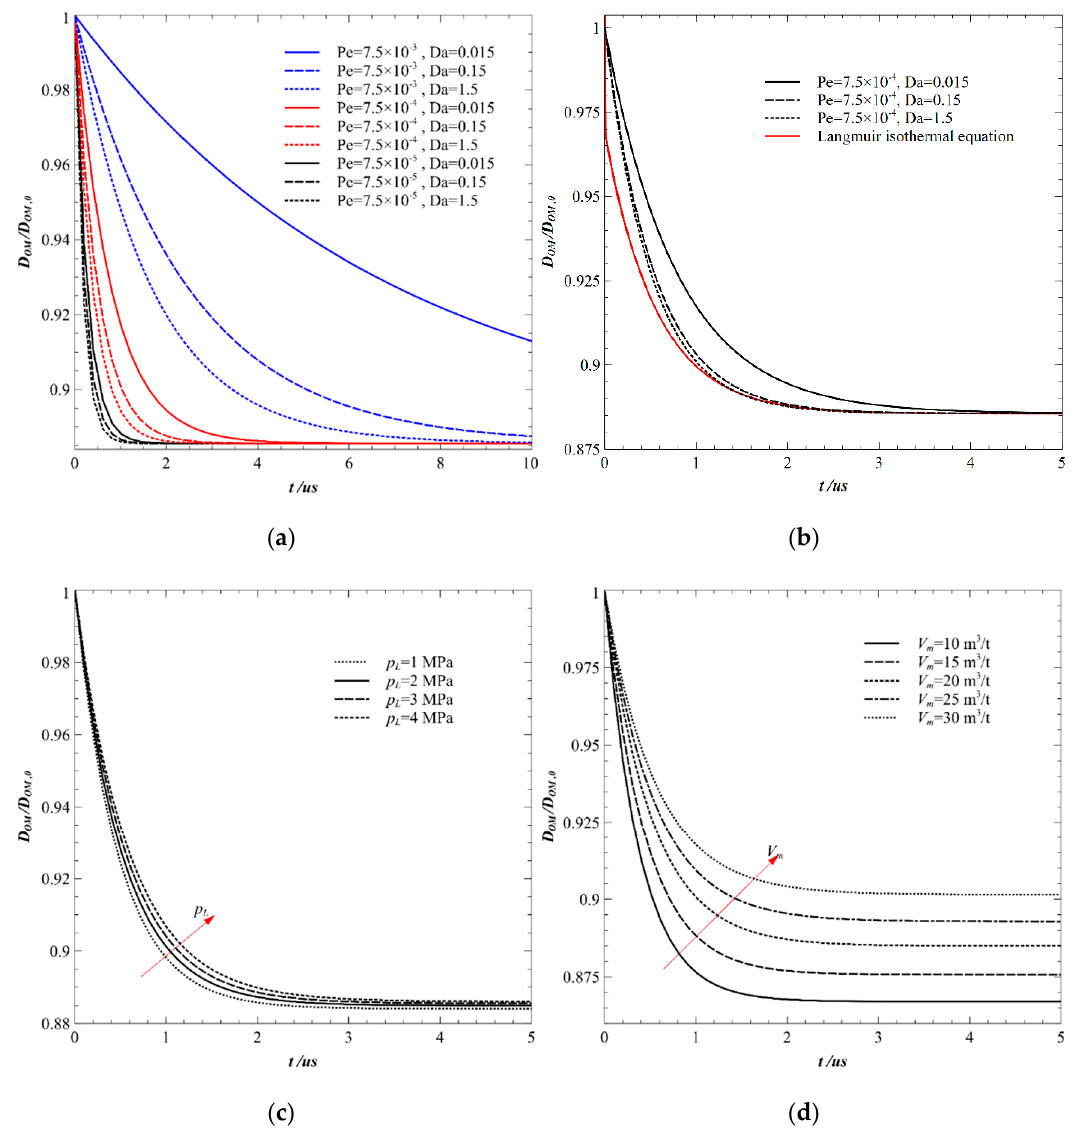
Figure 8. Changes of the global diffusion coefficient (GDC) with the adsorbed layer. ( a ) The variation of the GDC for 9 groups of Pe and Da , ( b ) the variation of the GDC at Pe = 7.5 × 10 − 4 , ( c ) the effect of p L on diffusivity, and ( d ) the effect of V m on diffusivity.